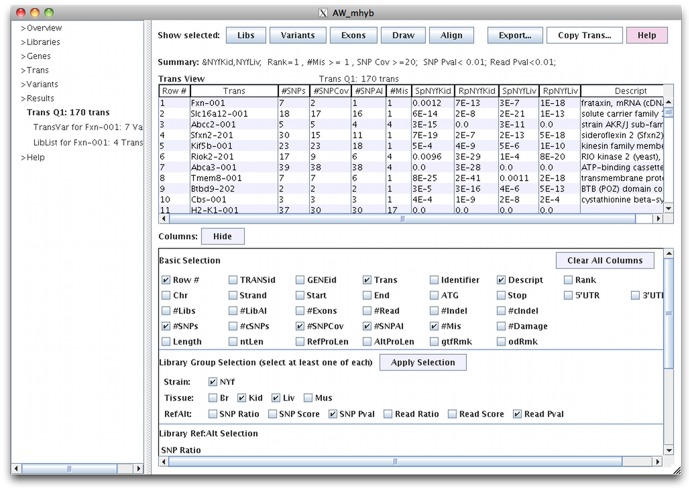
viewAW transcript table.The columns are shown in the lower panel; when an adjoining box is checked, the corresponding column is shown in the table. Selecting “Hide” closes the column listing. The SpNYfKid and SpNYfLiv columns are the SNP coverage p-values. The RpNYfKid and RpNYfLiv are the read counts p-values. The #SNPCov is the number of SNPs with ≥20 reads for any library, #SNPAI is number of SNP that are AI (p-value <0.05) for any library, and #Mis is the number of missense SNPs. #SNPCov and #SNPAI take into account all four libraries, where only two are shown but the others can be viewed by selecting their respective column box next to “Tissue”.